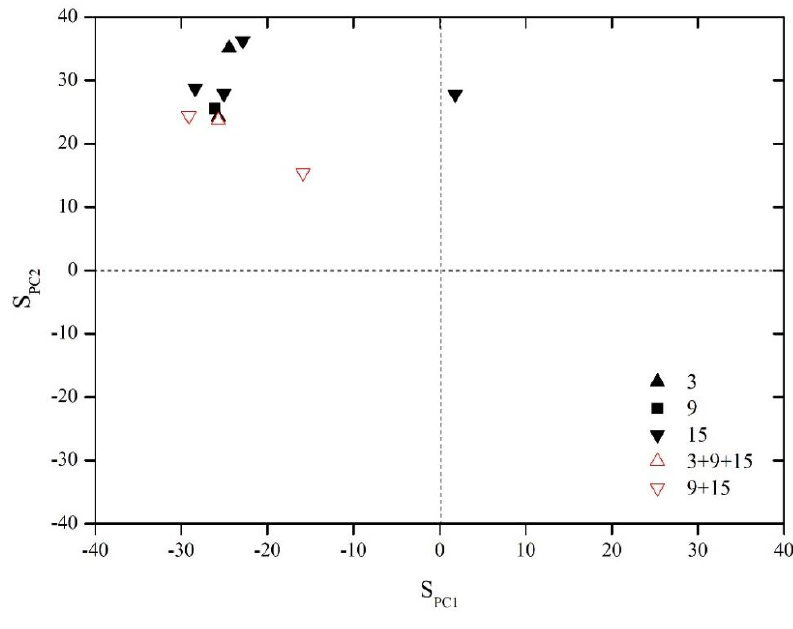
Figure 6. Load scores of produced water samples on principle components.